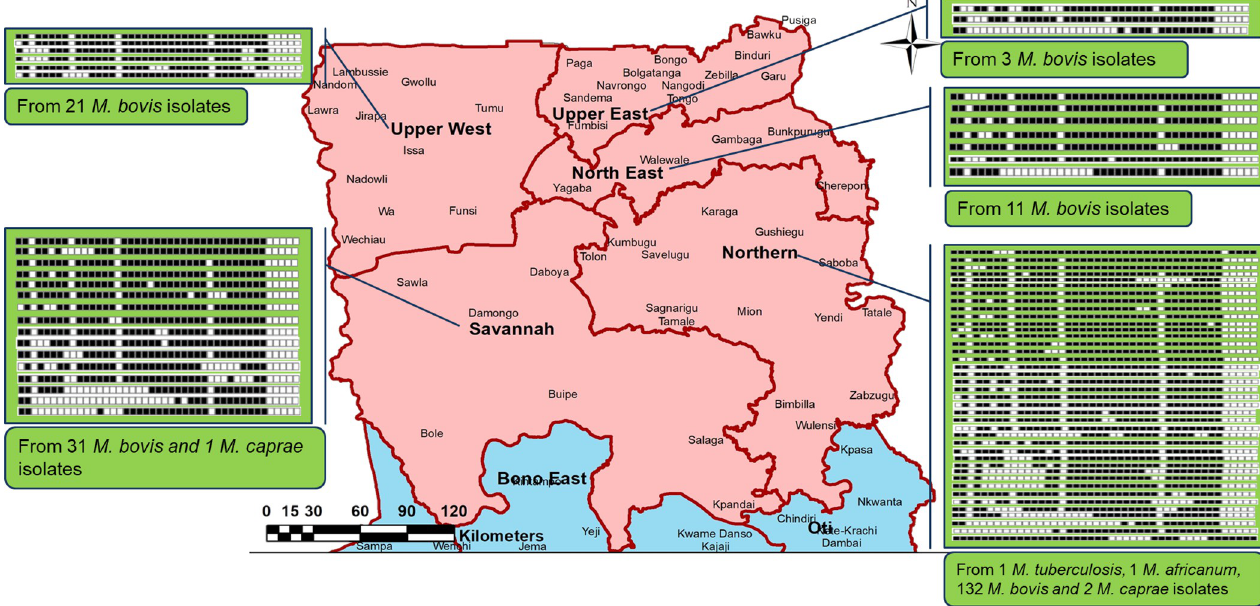
Fig 7. Spatial distribution of spoligotypes. The base map as well as the copyright information for use of the base map files can be obtained at https://data. humdata.org/dataset/cod-ab-gha. No changes were made to the base map